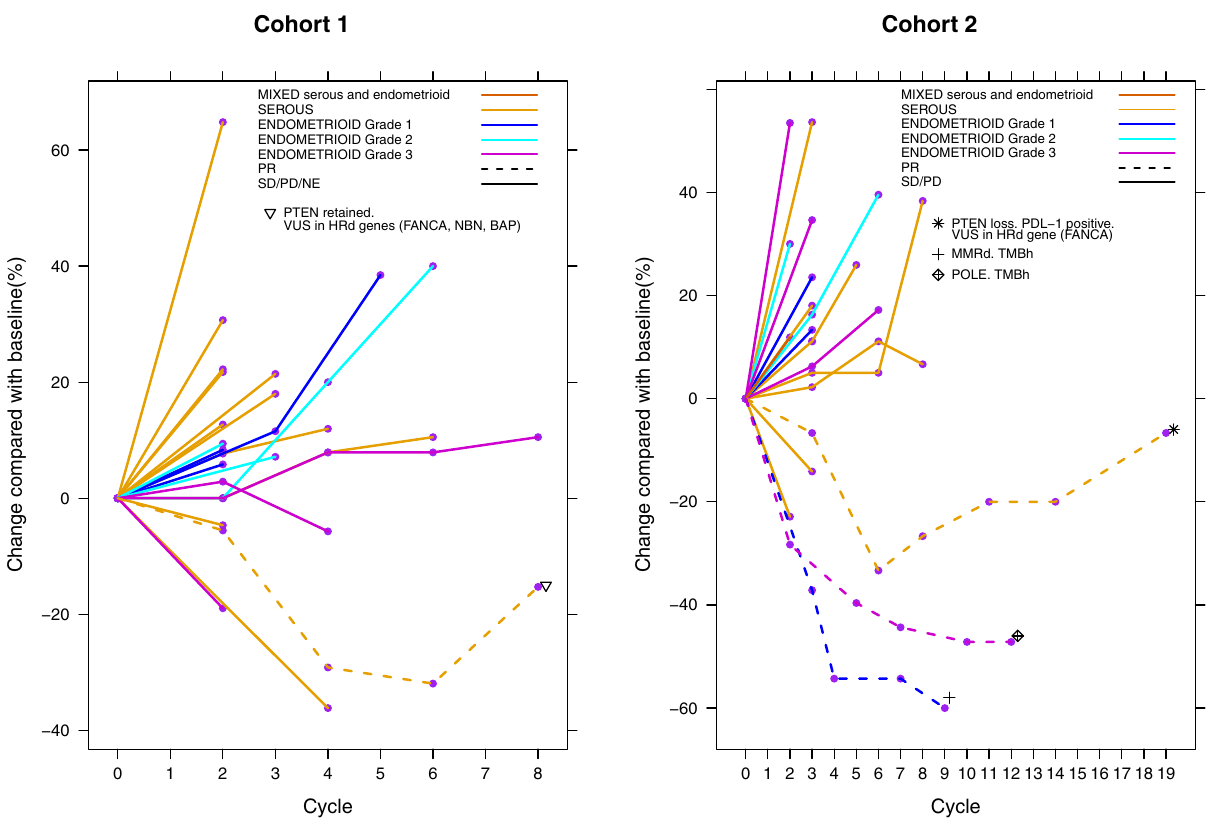
Fig. 2| Spiderplot showing thebestresponseasperRECIST 1.1 criteriaand durationofresponseasperhistologicalsubtype. Cohort1withniraparib monotherapy ( n =23), and Cohort 2 with niraparib and dostarlimab ( n